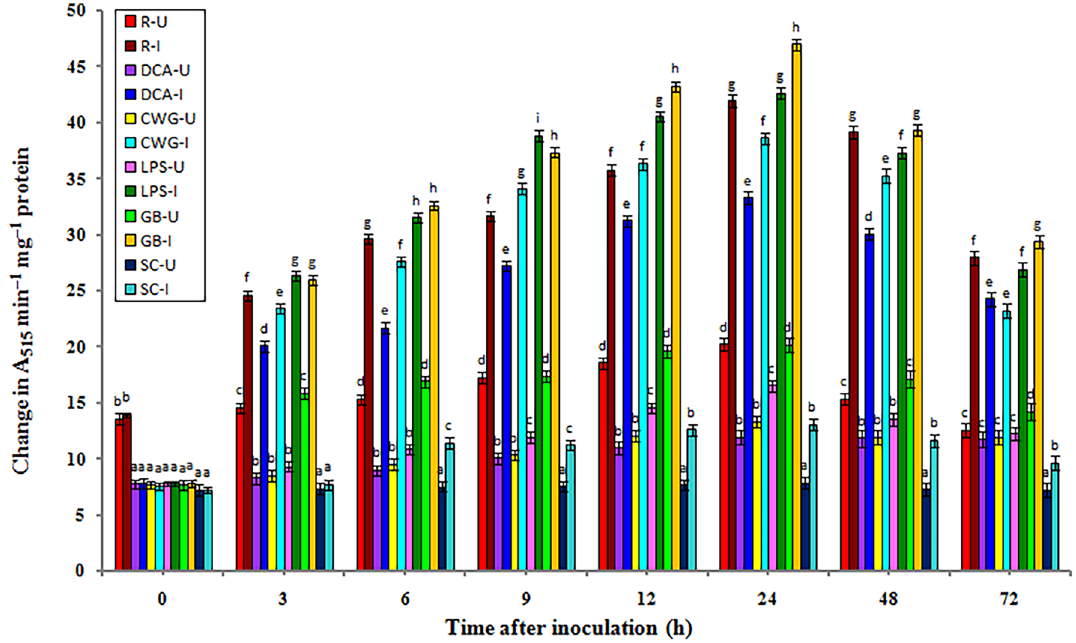
Figure 3. Temporal pattern of PPO activity in 2-day old P. glaucum seedlings with (I-inoculated) or without (U-uninoculated) Sclerospora graminicola inoculation. R—resistant, S—susceptible, DCA—3,5- Dichloroanthranilic acid treated, CWG—Cell Wall Glucans isolated from the endophyte Trichoderma hamatum UOM 13, LPS—Lipopolysaccharides isolated from bacteria Pseudomonas fluorescens UOM 14, GB— Glycinebetaine an amino acid derivative. Bars indicate standard errors; means with different superscripts are significantly different, as shown by Tukey’s HSD test ( p ≤